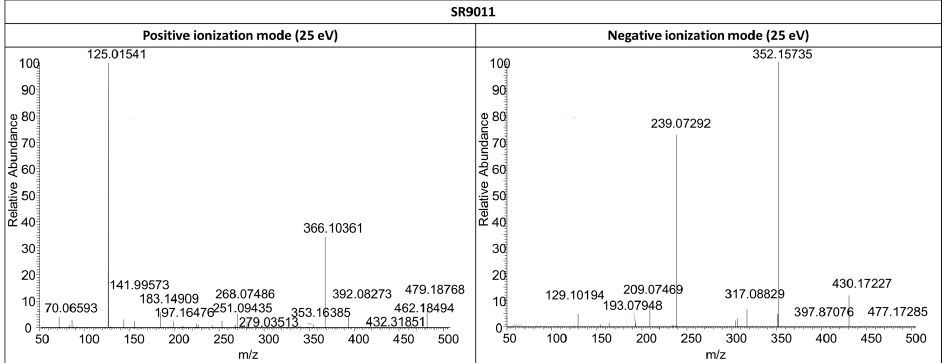
Figure 5. LC–HRMS/MS product ion scan mass spectra of SR9011 in both positive ( left column ) and negative ( right column ) ionization mode at a collision energy (CE) of 25 eV.